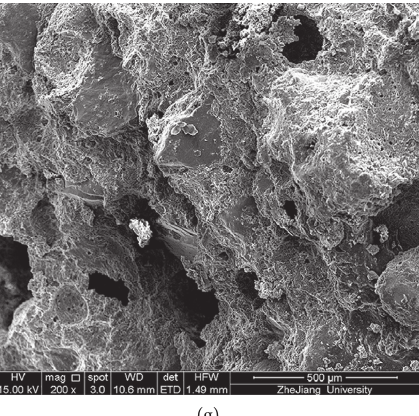
Figure 8: Free asphalt in hardened specimens of (a) CAM, (b) CAMS1, (c) CAMS2, (d) CAMS3, (e) CAMT1, (f) CAMT2, and (g)